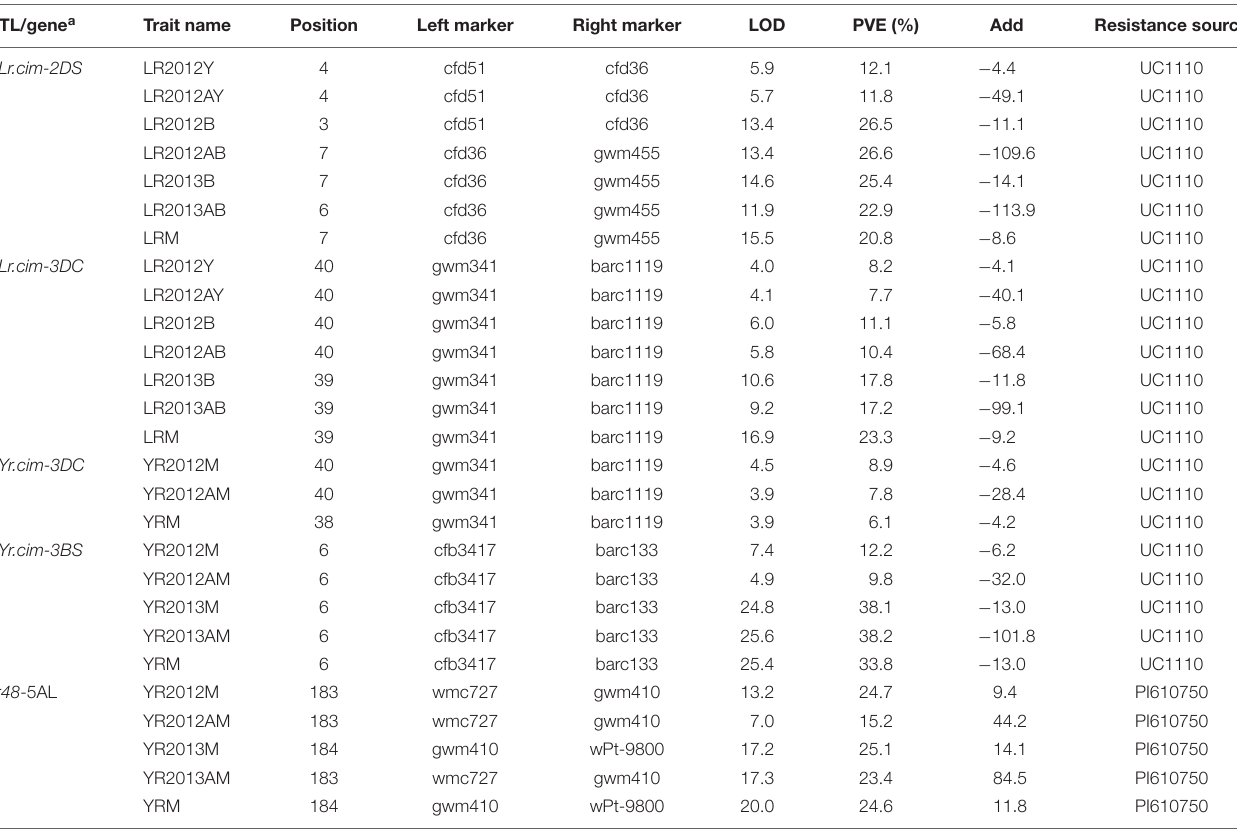
TABLE 2 | Quantitative trait loci (QTL) detected in the UC1110/PI610750 RIL population for adult plant resistance to leaf rust (Ciudad Obregón LR2012Y, El Batán LR2012B and LR2013B) and stripe rust (Toluca YR2012 and YR2013); traits include the area under the disease progress curve (AUDPC, viz. LR2012AY) and the mean of final disease severity over all environment (LRM and YRM).